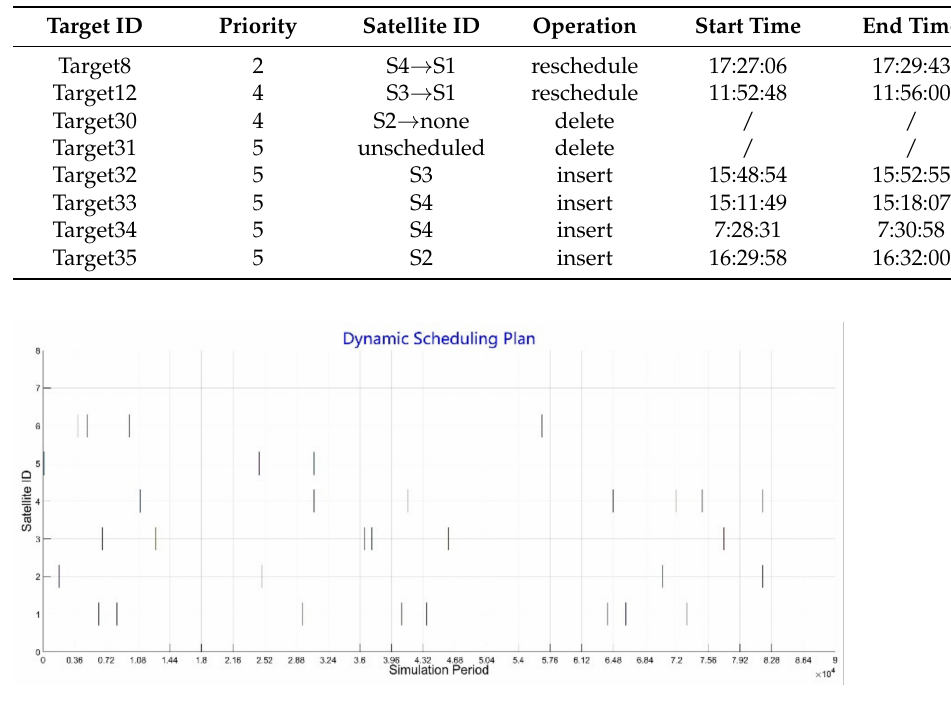
Figure 8. Gantt chart of dynamic scheduling. Table 9. Simulation results of dynamic